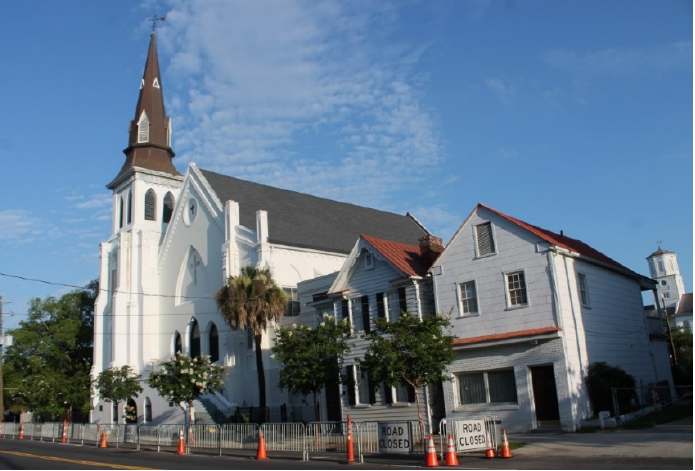
Figure 16. Emanuel AME Church, Charleston, South Carolina. Image by the author. June 2017.